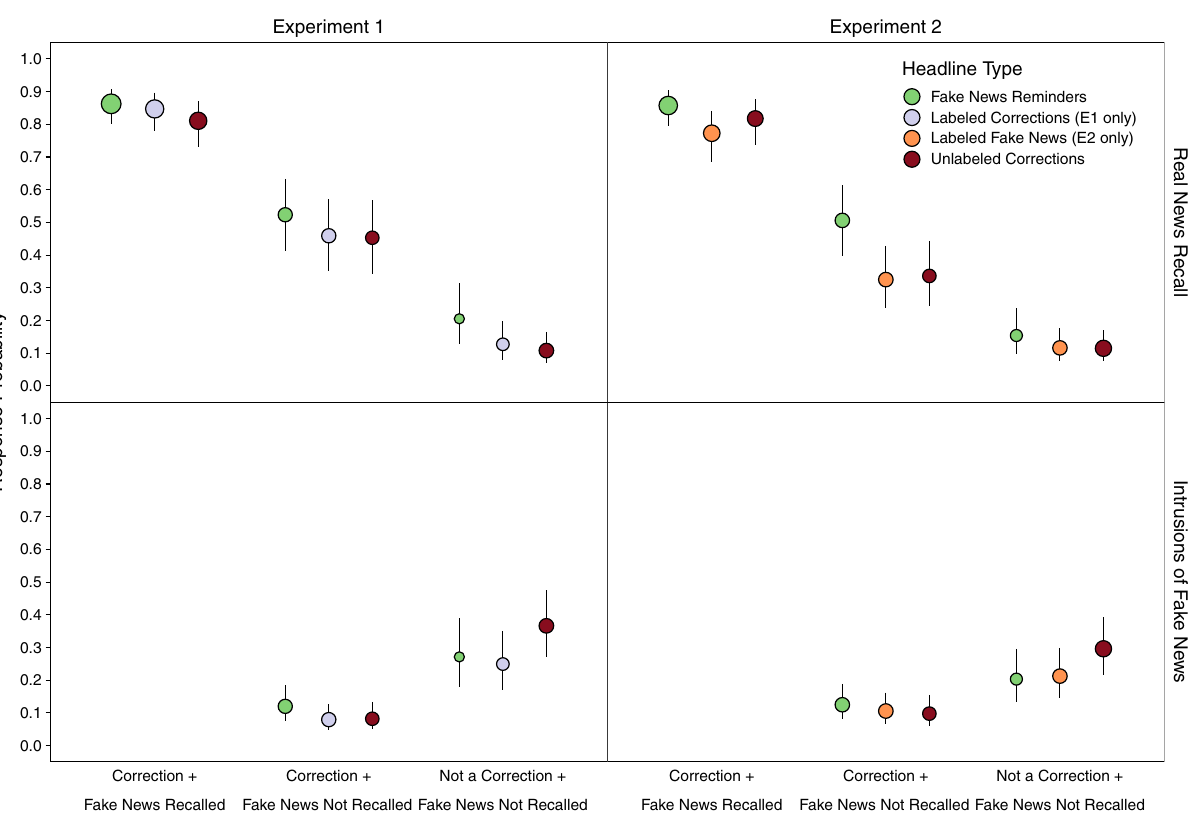
Figure 3. Probabilities of real news recall and intrusions of fake news conditioned on correction classifications for each correction headline type condition. Points are probabilities estimated from mixed effects models; error bars are 95% confidence intervals. Point sizes indicate for each cell the relative proportion of observations, which are also displayed in Supplementary Table S4. Values are not displayed for intrusions for classified corrections when fake news was recalled due to sparse